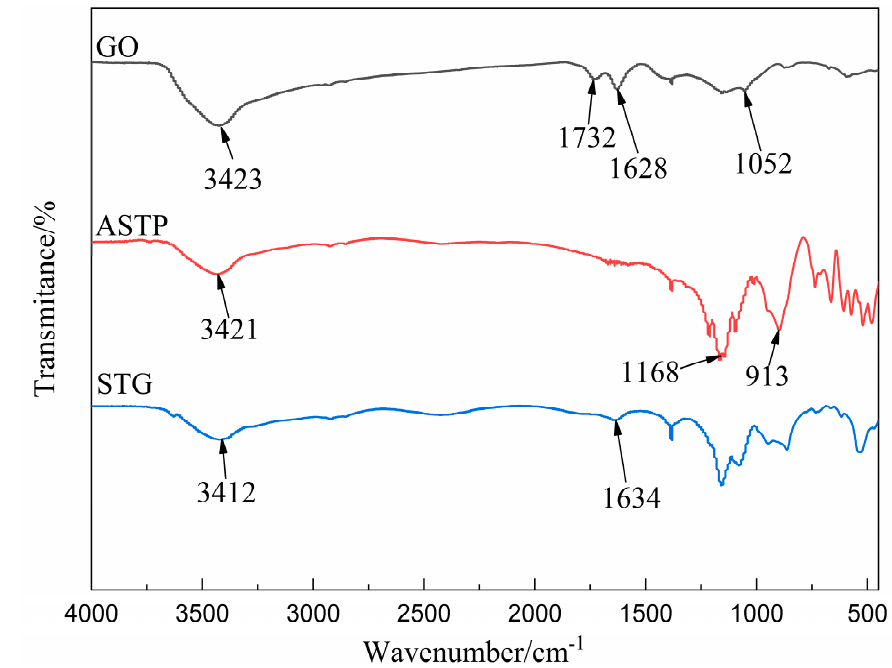
Figure 2. FTIR spectra of GO, ASTP and STG.